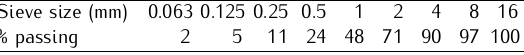
Table 5. Grain size distribution for the sandy gravel